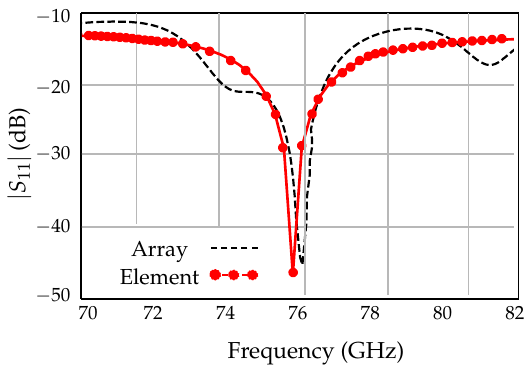
Figure 12. Simulated reflection coefficient of the 77–GHz antenna element and array.